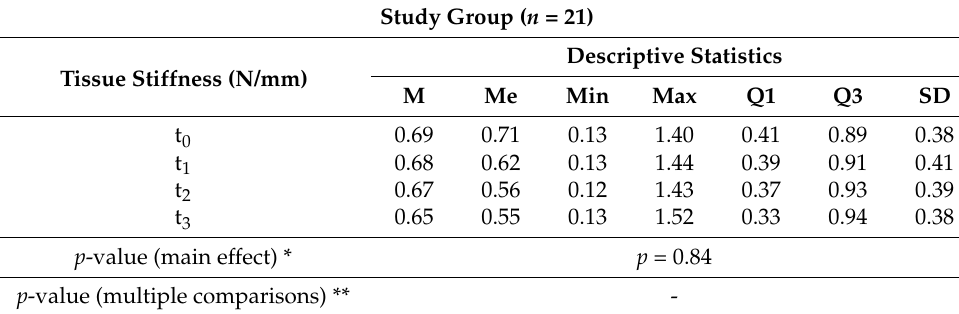
Study Group ( n = 21)